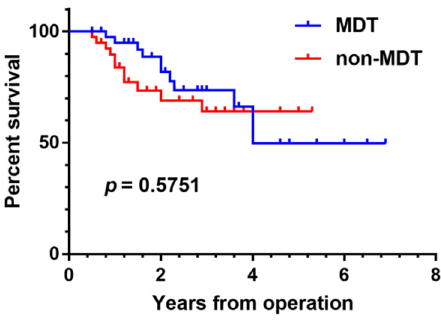
Figure 4. Survival analysis of patients with osteosarcoma who were discussed by the MDT due to pulmonary nodules versus undiscussed patients with osteosarcoma and pulmonary nodules.